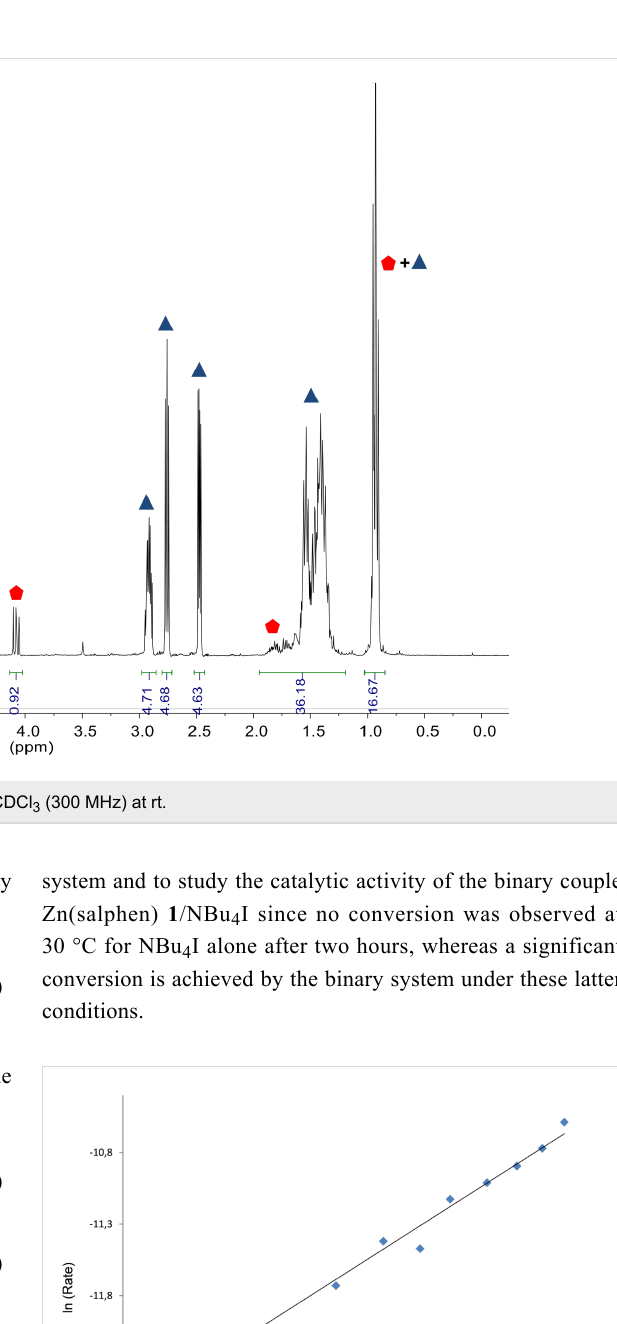
To evaluate the function of the Zn complex and the NBu 4 I